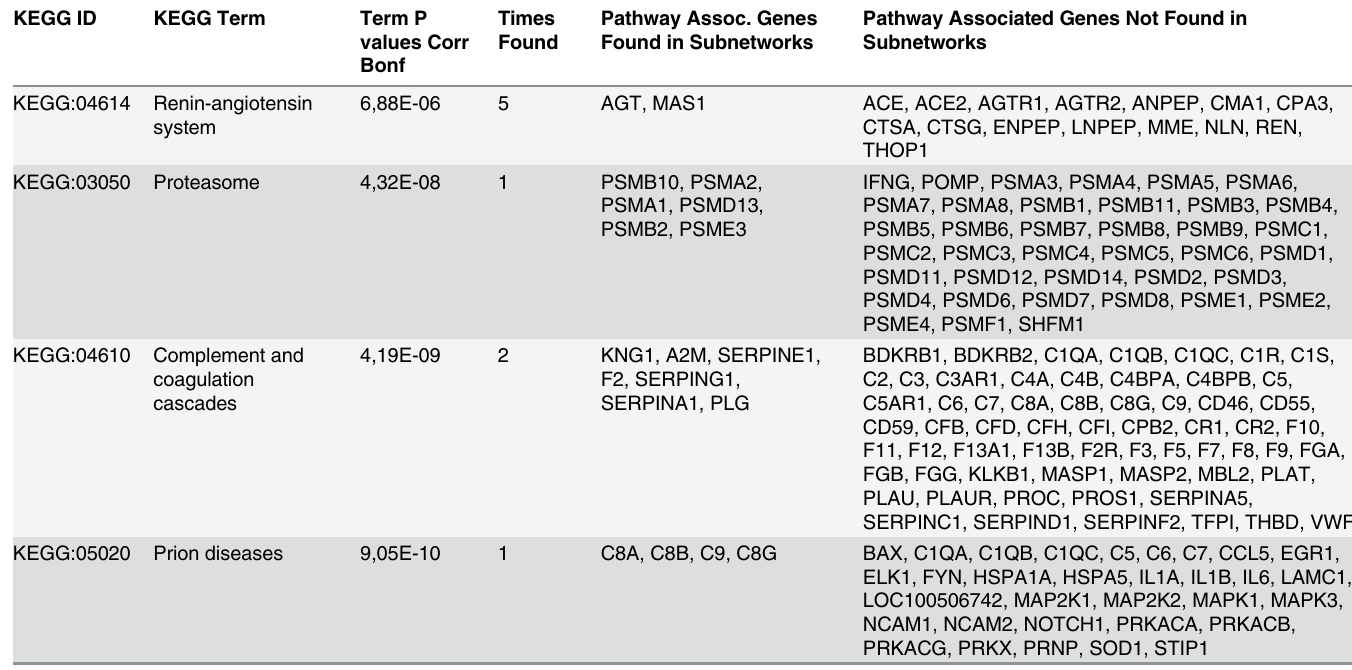
Table 2. Molecular pathways and associated proteins in CIS